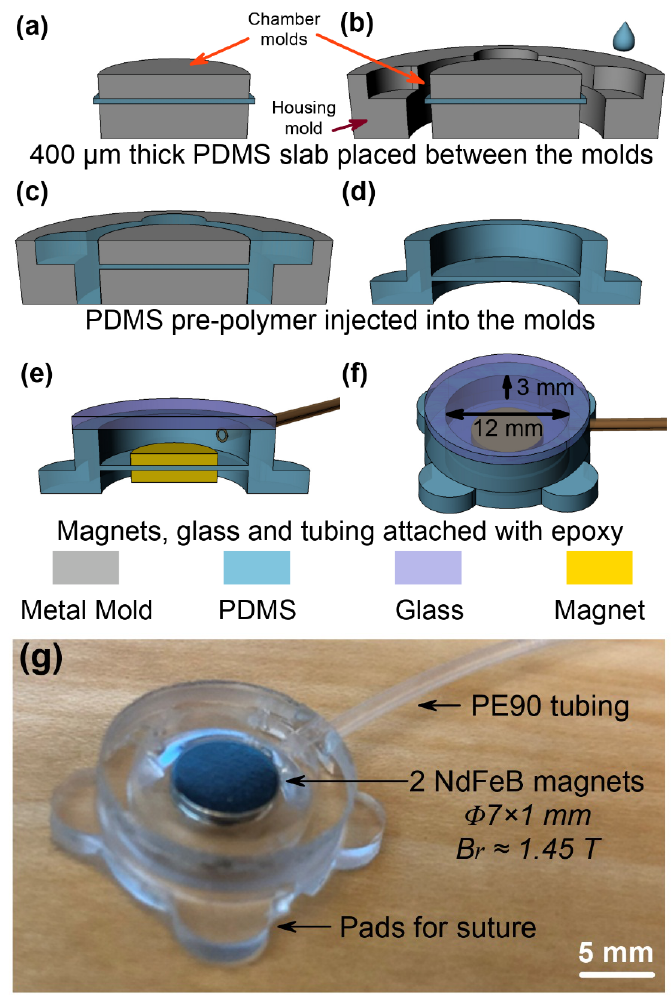
Figure 2. Schematic diagrams of the fabrication process: ( a ) 400 μm thick polydimethylsiloxane (PDMS) membrane clamped between two pieces of stainless-steel cylindrical chamber mold, ( b ) chamber mold and PDMS membrane placed into the center of housing mold and injected with PDMS pre-polymer, ( c ) PDMS curing in oven, ( d ) cured PDMS peeled off from the molds, ( e ) borosilicate glass, NdFeB magnets, and PE90 tubing attached, ( f ) schematic in perspective views and ( g ) optical image of the fabricated magnetic microfluidic pump with two NdFeB magnets (N50 grade) of size Φ7 × 1 × 1 mm.